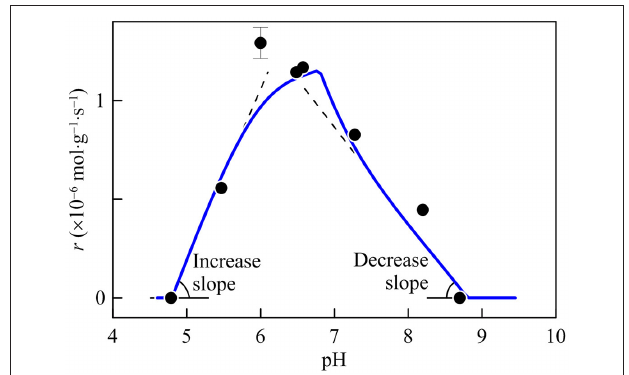
FIGURE 8 | Variation with time in the rate of acetoclastic methanogenesis. Solid line is the prediction by the pH factor and the thermodynamic factor, assuming that acetate is abundant and the kinetic factor F D takes a value of one; data points are computed from the experimental results of Methanosarcina mazei , using a growth yield of 2 g · (mol acetate) − 1 (Maestrojuan and Boone, 1991). The slopes of increase and decrease are 0.86 and 0.49 mol · g − 1 · s − 1 per pH unit,